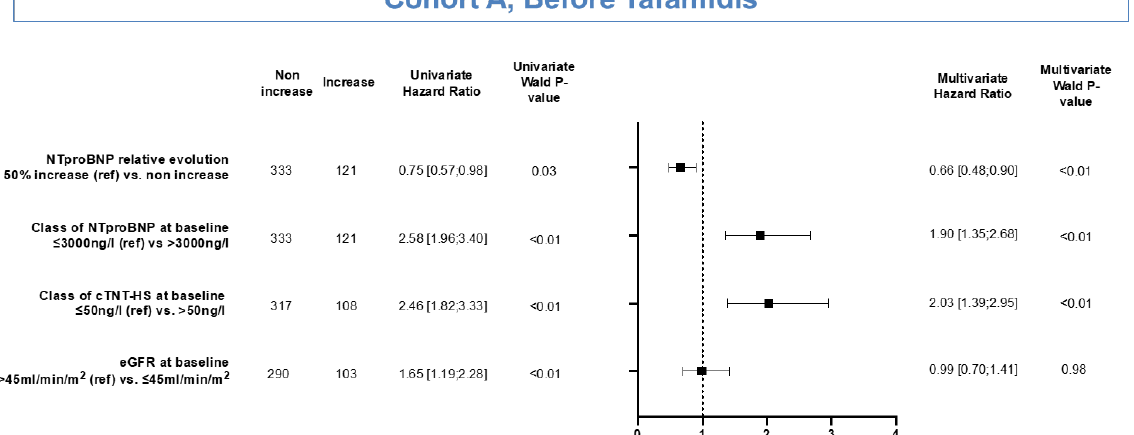
Figure 5. Univariate and multivariate analyses to identify factors associated with extended event-free survival in patients in Cohort A.